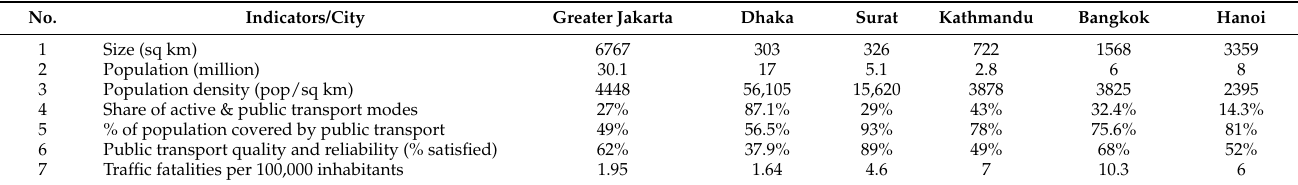
Table 1. Key city characteristics and transport